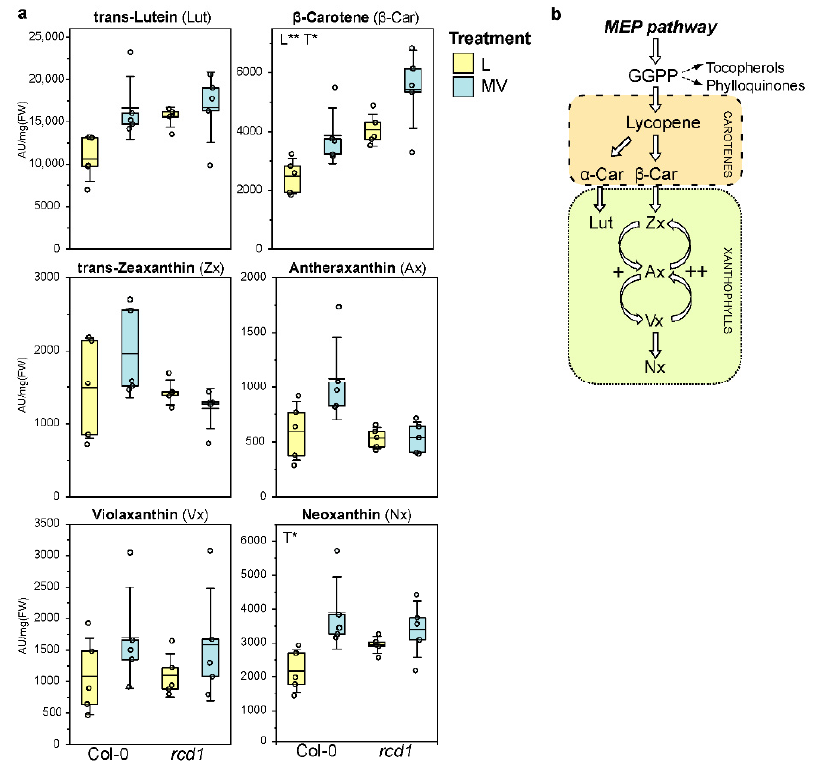
Figure 3. ( a ) Pigment levels (AU/mg[FW]) in Col-0 and rcd1 plants in control/light conditions (L), and after paraquat exposure (MV), and ( b ) their biosynthesis pathway. Dots represent data points ( n = 4–5); the box represents 25 and 75 percentiles; the line marks the mean and the whiskers the standard deviation. The main effects of plant line (L) and treatment (T) and their interaction (L × T) were tested with two-way ANOVA (FDR-adjusted p -value < 0.05 *, <0.01 **). + indicates epoxidation, ++ de-epoxidation reactions.